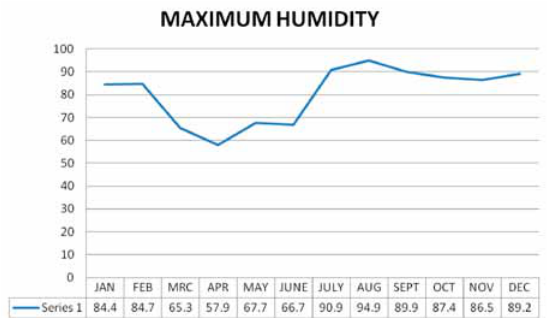
fig. 22. Minimum humidity recorded through the year at 2 PM in the